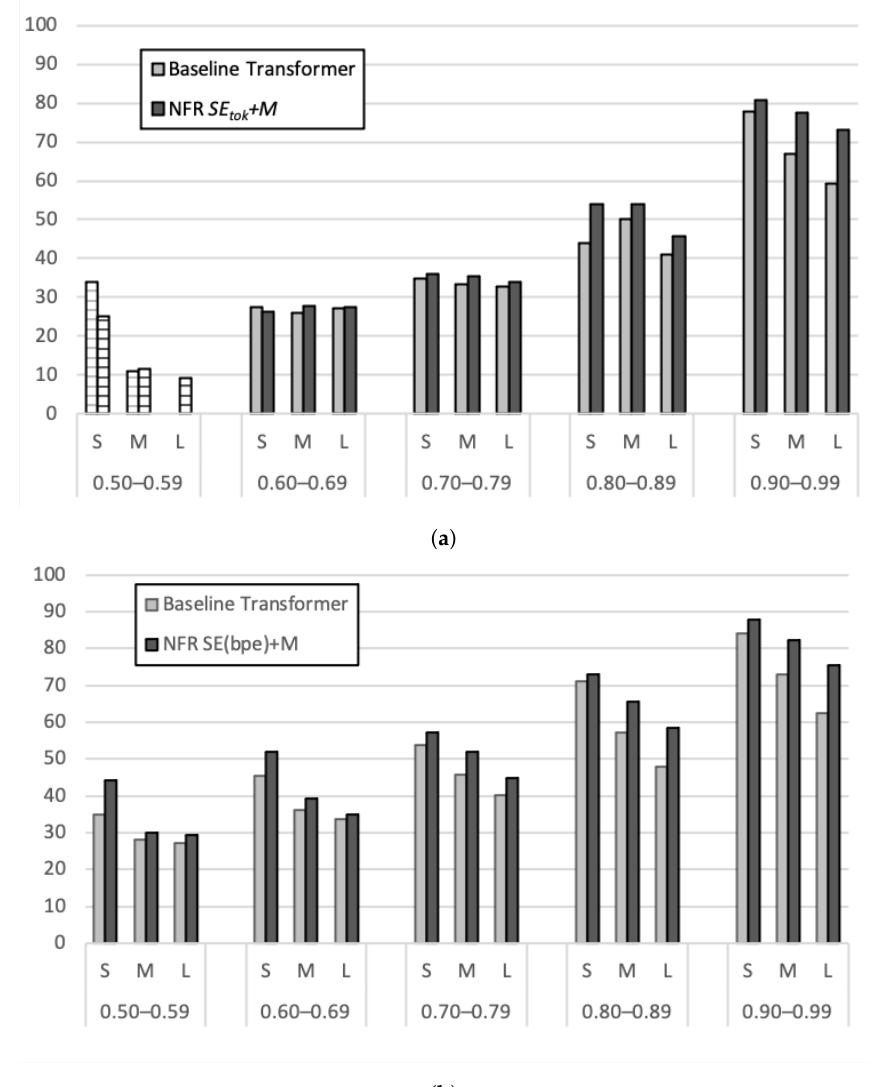
Figure 3. Comparison of ( a ) SE tok +M and ( b ) SE bpe +M with Baseline Transformer for different match ranges and sentence lengths, EN-HU. Note that in ( a ) the bin sizes in the lowest match range are very small (i.e., between 3 and 9 sentences), so the reported BLEU scores for these bins are not reliable. S refers to sentences of length 1–10, M 11–25, and L over